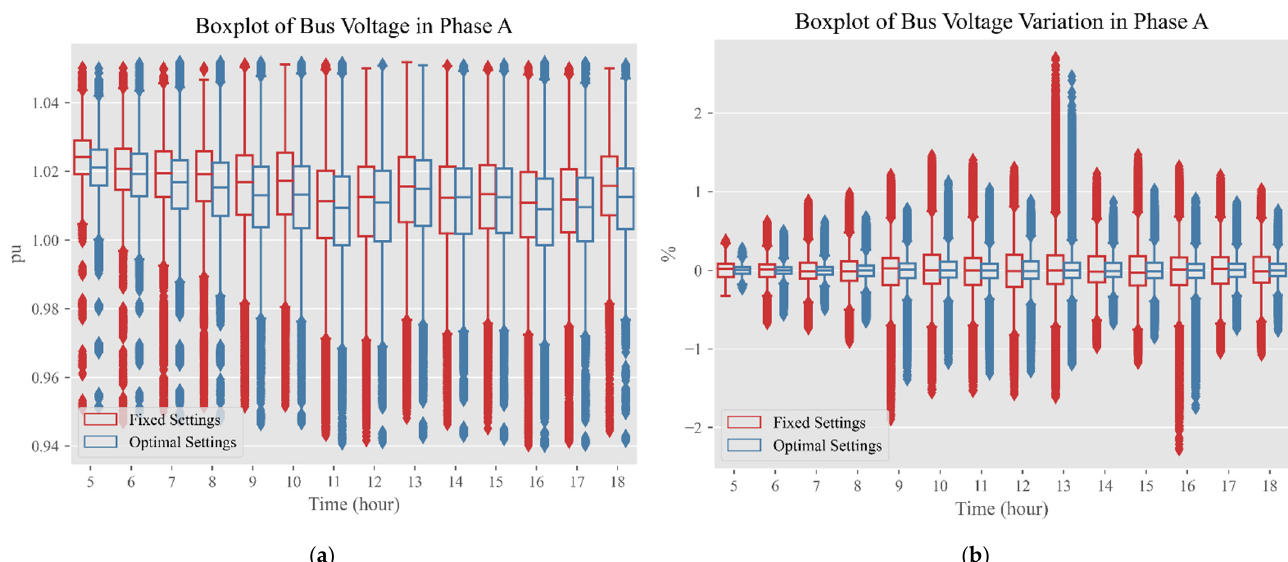
Figure 8. Boxplots of ( a ) bus voltage and ( b ) voltage variation in phase A for each hour with fixed and optimal volt-var control settings.